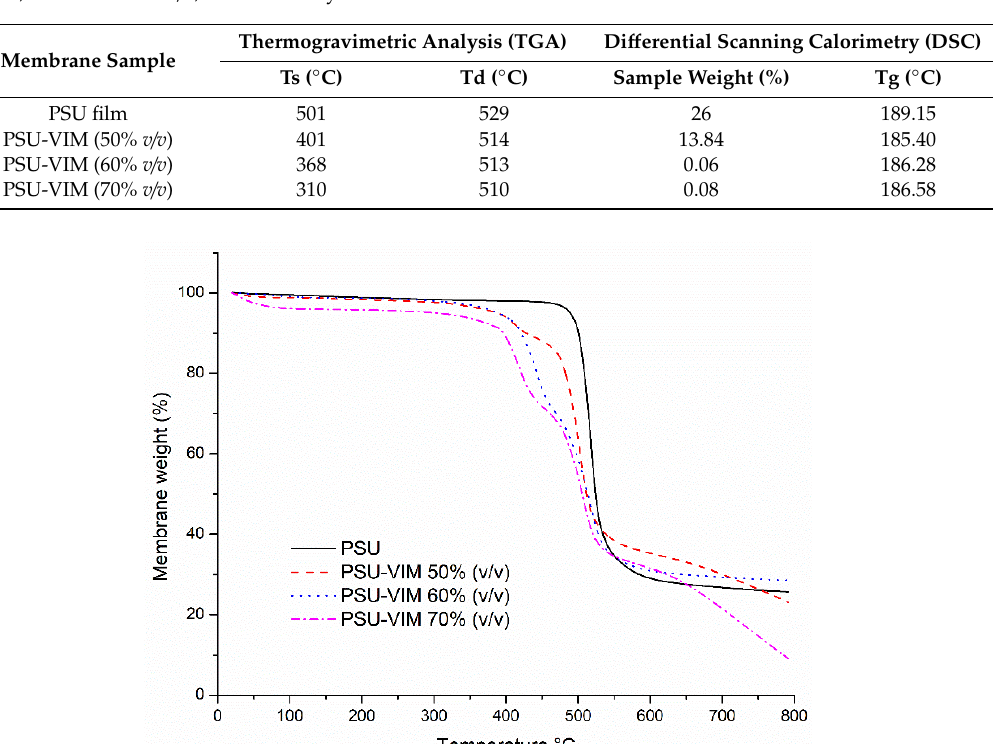
Table 2. Data of the thermal behavior of grafted PSU membranes with a solution of VIM monomer at 50%, 60% and 70% v/v, with 300 kGy of irradiation dose.